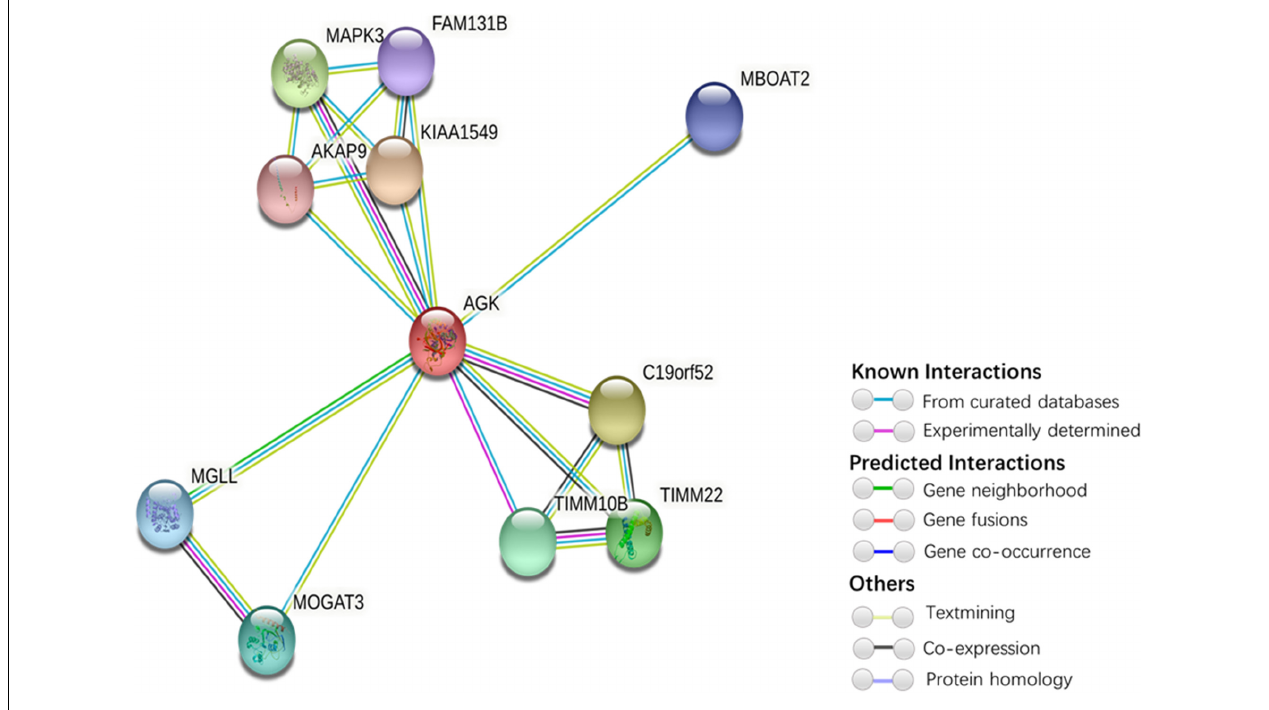
FIGURE 5 | Protein interaction network of AGK-related proteins. The protein–protein interaction network was generated by STRING (Szklarczyk et al., 2019). Network nodes represent proteins. Edges represent protein–protein associations (associations are meant to be specific and meaningful, i.e., proteins jointly contribute to a shared function; this does not necessarily mean they are physically binding each other). Kiaa1545, UPF0606 protein KIAA1549; C19orf52, mitochondrial import inner membrane translocase subunit Tim29; MAPK3, mitogen-activated protein kinase 3; TIMM22, mitochondrial import inner membrane translocase subunit Tim22; TIMM10B, mitochondrial import inner membrane translocase subunit Tim10 B; MOGAT3, 2-acylglycerol O-acyltransferase 3; MGLL, monoglyceride lipase; MBOAT2, lysophospholipid acyltransferase 2; FAM131B, protein FAM131B; AKAP9, A-kinase anchor protein